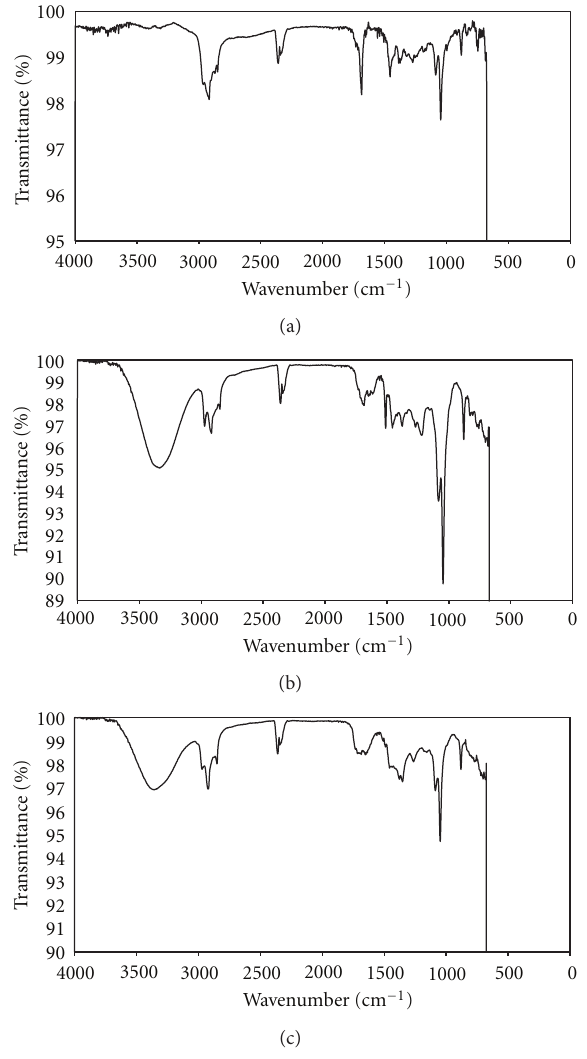
F 2: Infrared spectra recorded from alcoholic extracts of (a) rosemary, (b) oregano, and (c) basil.